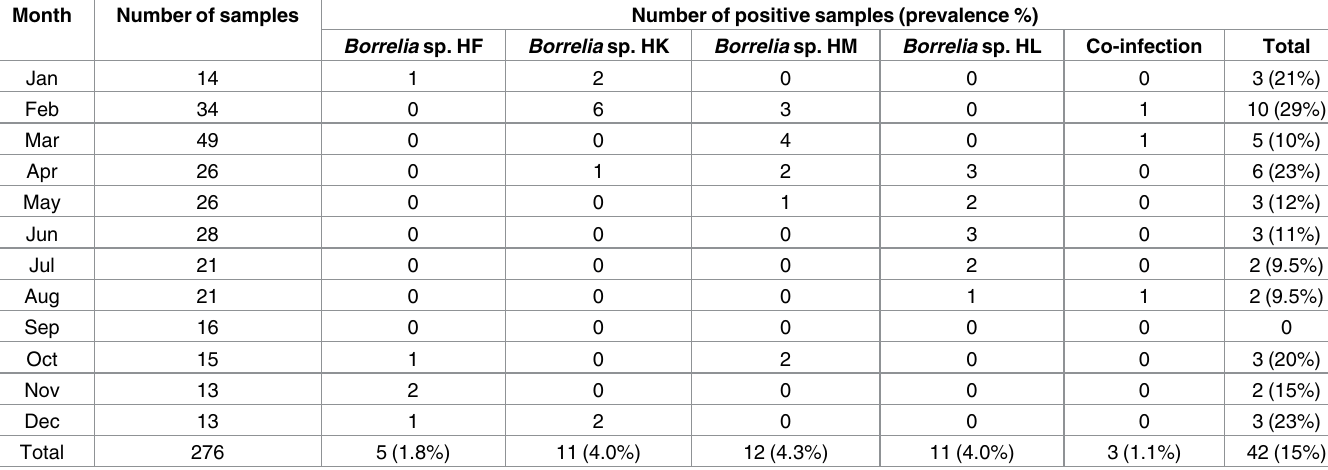
genotype was detected mostly in a specific tick species. Moreover, Borrelia sp. HM detected in ticks and wild animals in Shimonoseki in the western part of Japan was not genetically distin- guished from that detected in Hokkaido in the northern island of Japan in a previous study (Figs 1 and 2, Accession Number AB897887) [15]. In most cases, the genus Borrelia was trans- mitted by a particular tick species [4]. Thus, our results suggest that the bacterial genotypes detected in this study might be defined by the tick species from which they were detected. The group mean pairwise distances between Borrelia sp. HF, Borrelia sp. HK, and Borrelia sp. HM showed that they slightly differed in terms of flaB (mean pairwise distances over 99%). We ana- lyzed other housekeeping genes (Figs 3 and 4), but some genes could not be amplified using the representative primer sets. Recently, MLSA was used for the intra- or inter-species charac- terization of Lyme disease borreliae and some hTBRF borreliae [26, 30, 31, 43]. We used MLSA to analyze Borrelia sp. HM strain tHM16w (S1 Fig), but the amplification efficiency was low, even when we used strain-derived DNA. Moreover, nifS , pepX and uvrA were not Table 5. Prevalence of Borrelia sp. in sika deer collected from Shimonoseki, Yamaguchi Prefecture. Month Number of